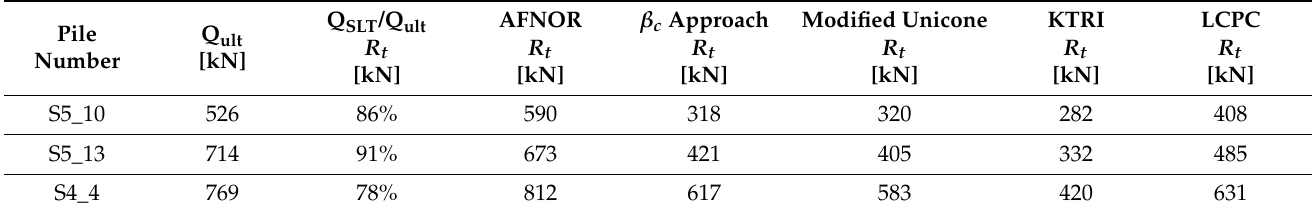
Table 1. Measured and predicted bearing capacities of the reference piles.